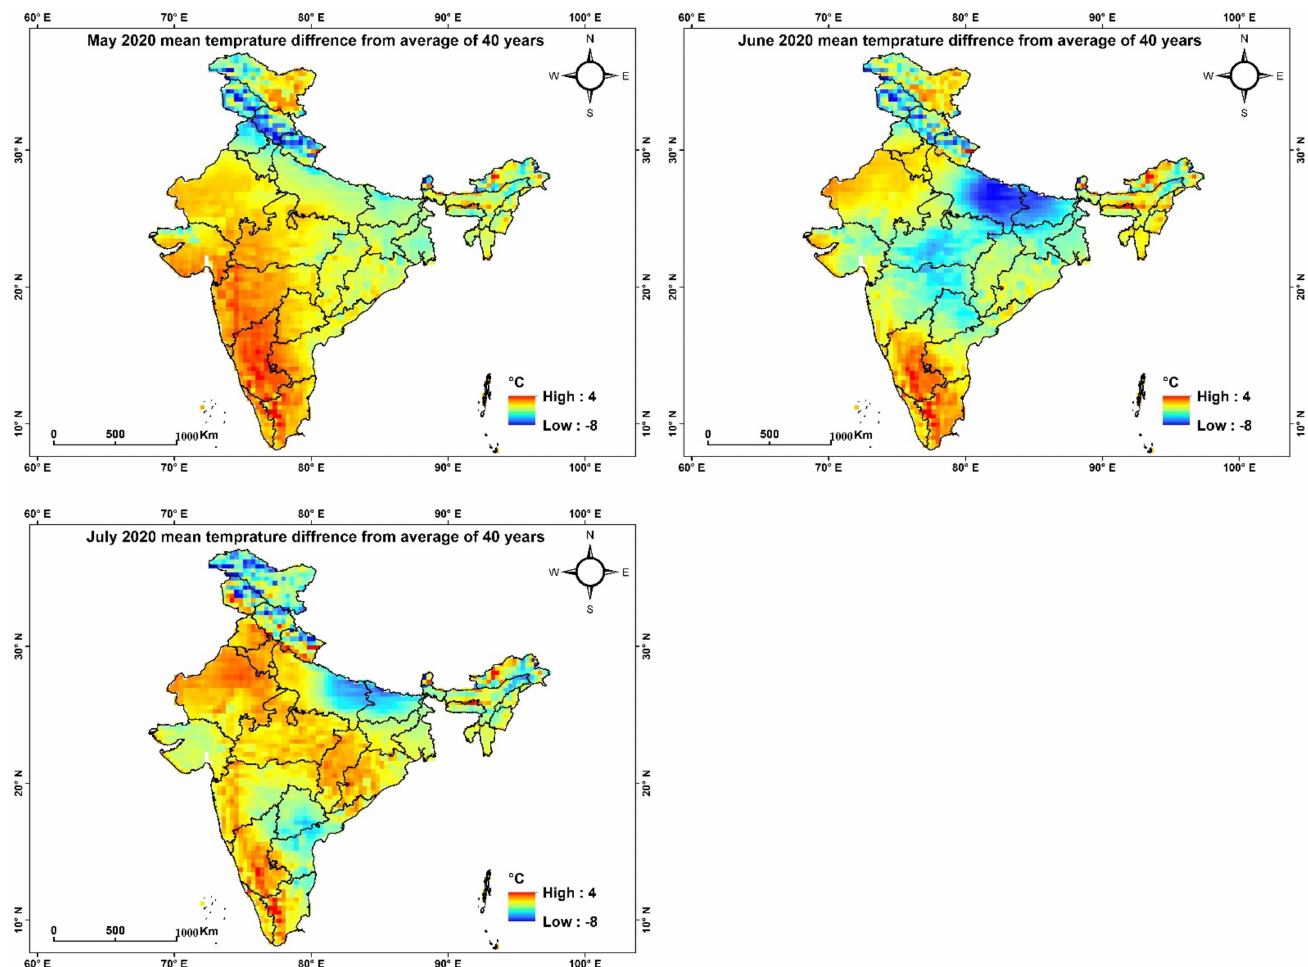
Figure 6. Mean temperature difference from the average of 40 years (1980–2020). Higher and lower values indicate increased and decreased temperatures, respectively, compared to